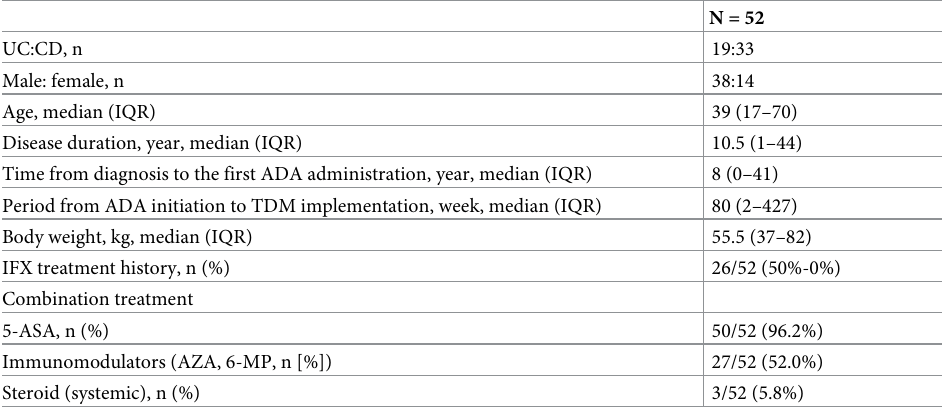
Table 1. Baseline characteristics of